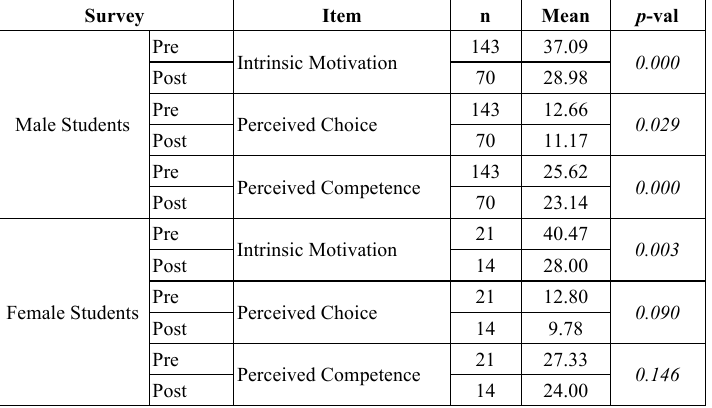
Table 3. Comparison of Pre- and Post-survey results -